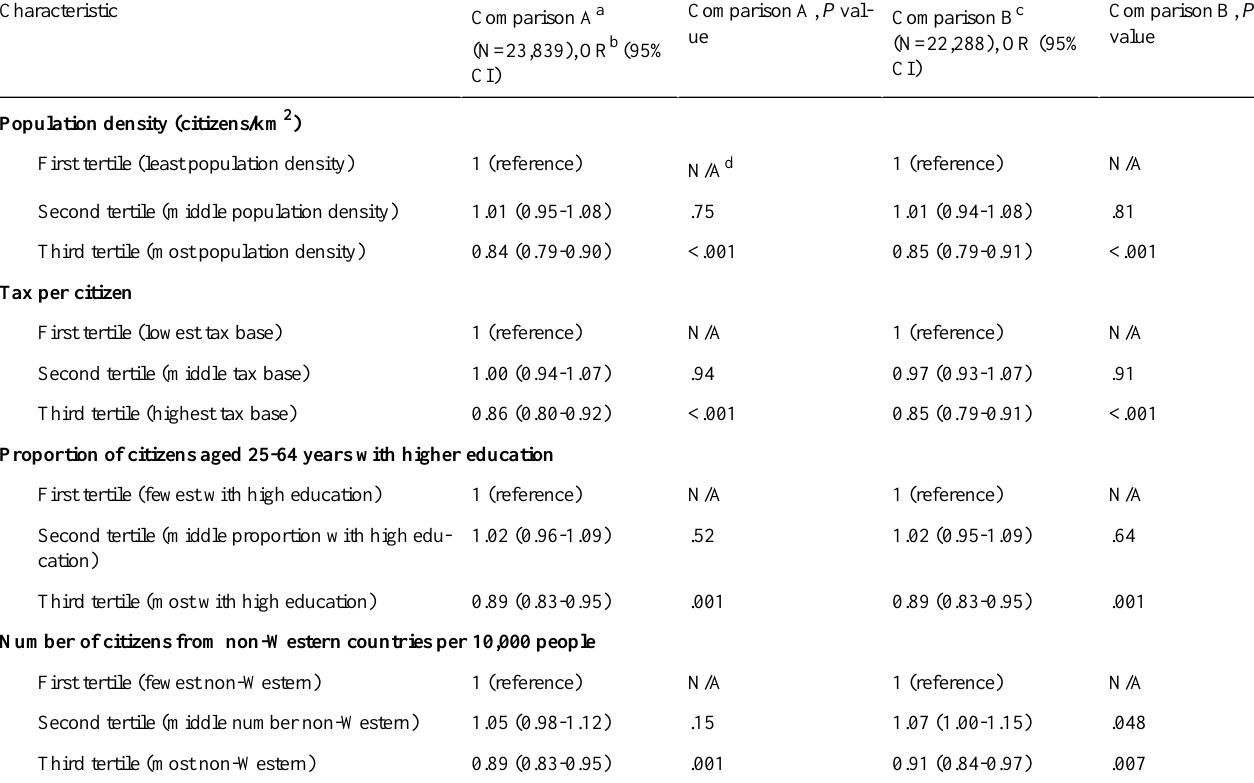
Table 6. Comparison of municipality-level characteristics in responders and